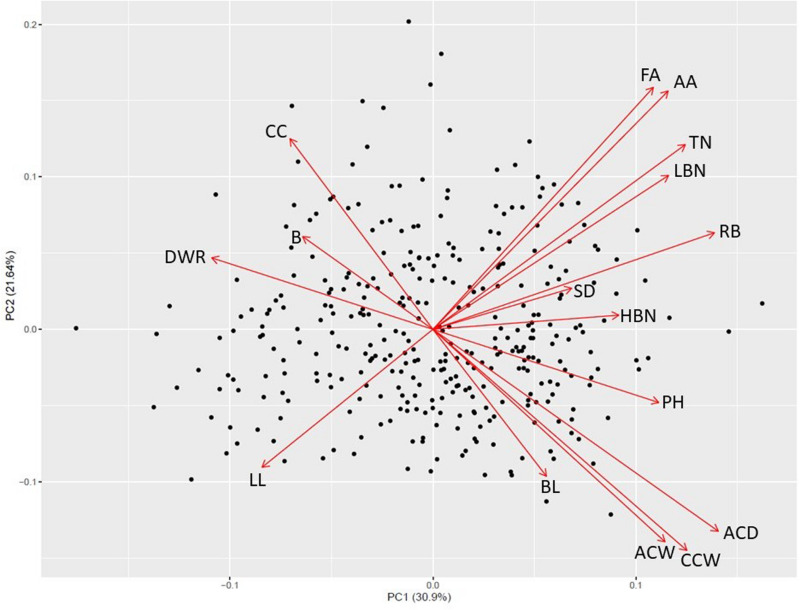
First and second principal component axes for 340 Maximilian sunflower individuals segregating for apical dominance. FA, First anthesis; AA, average date of anthesis; TN, total nodes; LBN, lowest branching node; RB, reproductive budding; SD, stem diameter; HBN, highest branching node; PH, plant height; ACD, average capitula depth; CCW, central capitulum width; ACW, average capitula width; BL, branch length; LL, leaf length; DWR, capitulum depth:width ratio; B, branches; CC, total capitula count.